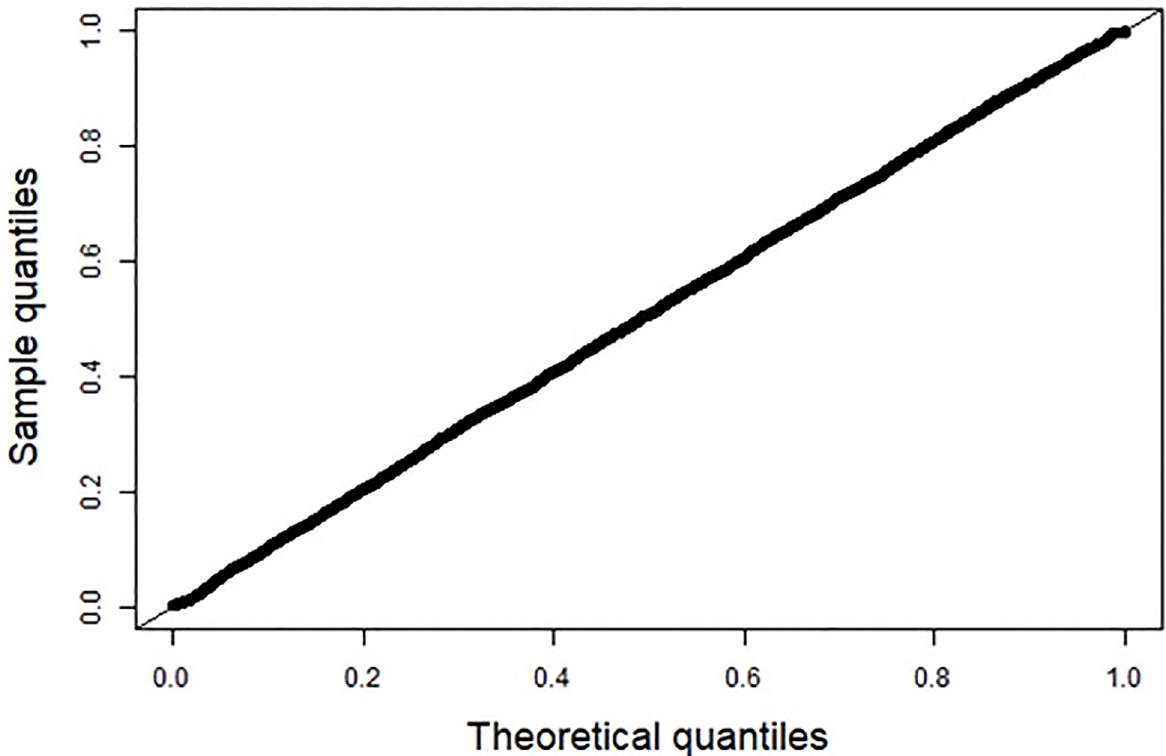
Fig 2. Quantile-quantile plot of model calibration: Survival probability at observed time of event.